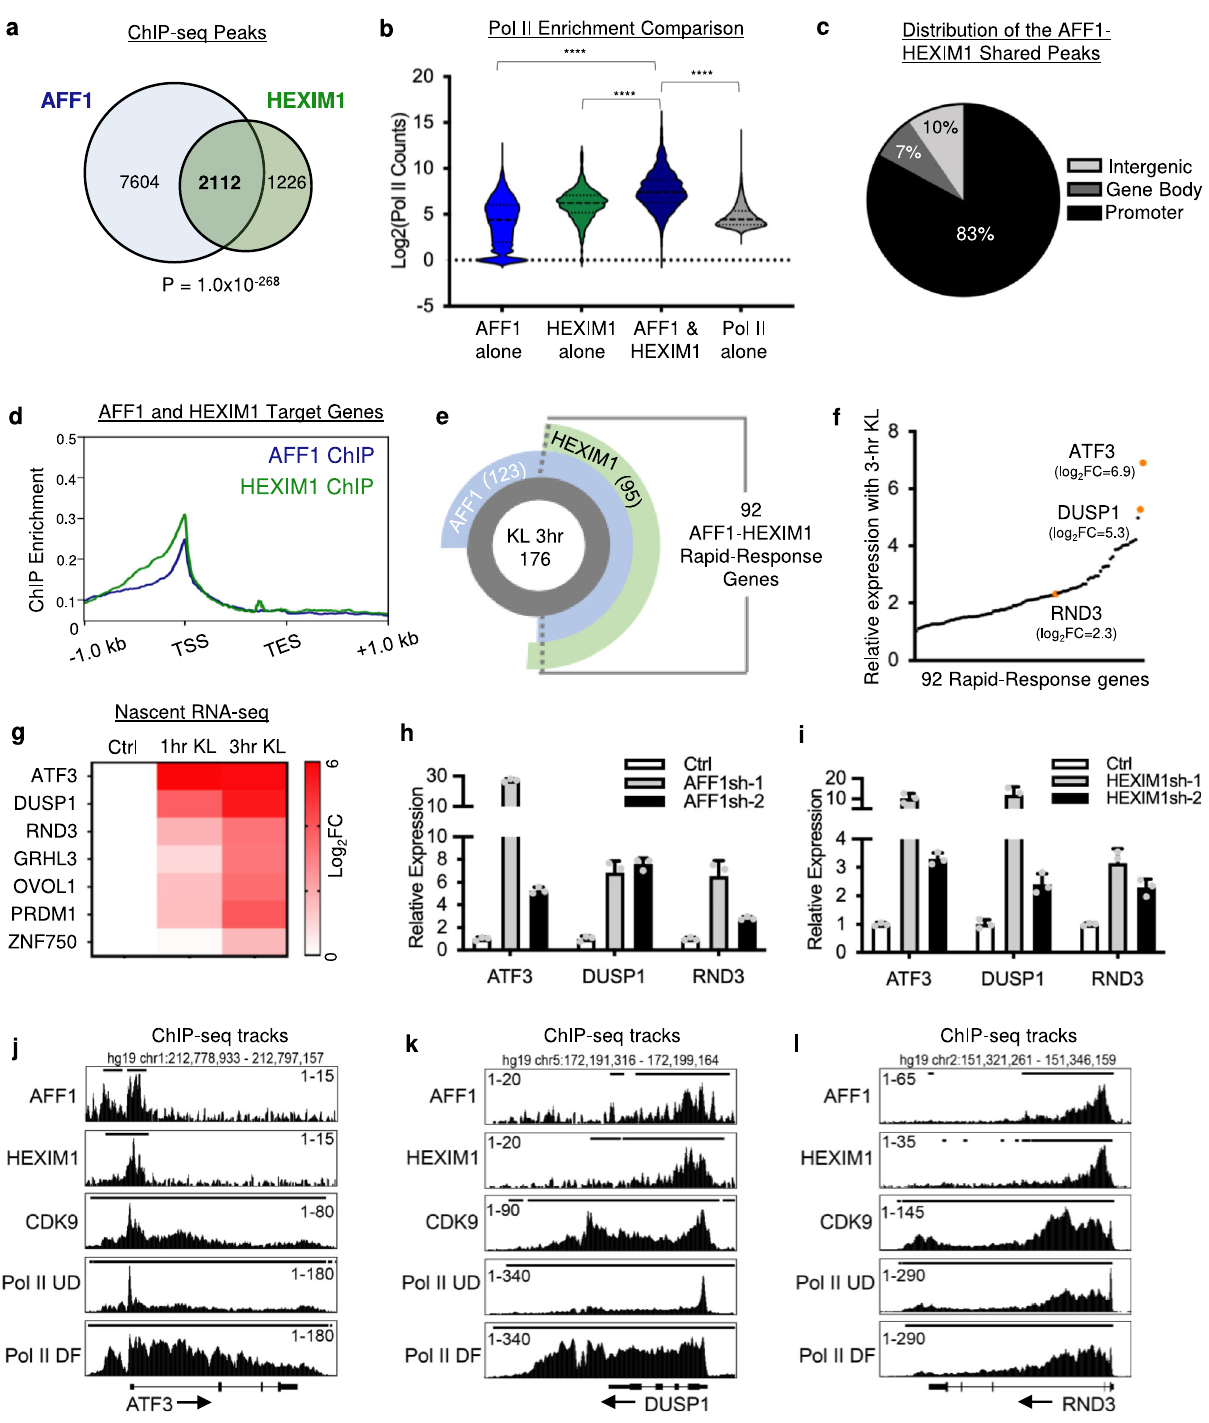
Fig.5|HEXIM1andAFF1colocalizetodirectlysuppressrapid-responsetargets. a Venndiagramshowingthesigni fi cantoverlapbetweenAFF1andHEXIM1ChIP-seq peaks (Fisher ’ s exact test, two-tailed, P =1×10 − 268 ). b Violin plot showing the sig- ni fi cantenrichmentoftotalPolIIcountsatChIP-seqcategories:AFF1uniquepeaks, HEXIM1 unique peaks, and peaks with Pol II but no HEXIM1 or AFF1 relative to overlapping AFF1 and HEXIM1 peaks (**** P <0.0001, two-tailed, unpaired t test). c Pie chart showing the peak distribution of AFF1 and HEXIM1 ChIP-seq data in promoters (transcription start site (TSS)±1kb), gene bodies (TSS±1kb through transcription end site), or intergenic regions. d Average pro fi le plot showing the overlappingenrichmentofAFF1andHEXIM1ChIP-seqsignalnearthepromotersof their shared target genes. e Shared target genes among AFF1 ChIP-seq, HEXIM1 ChIP-seq, and the signi fi cantly upregulated genes in keratinocytes with 3-hr KL